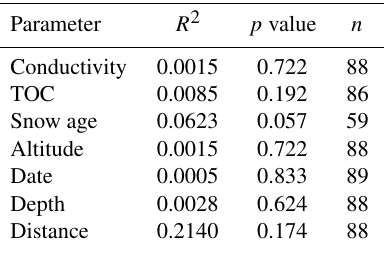
Table 2. Correlation analyses between T 50 values and different physicochemical and terrain parameters calculated with the Matlab standard linear fit model. R 2 values characterize the linear relation- ship between T 50 and the parameter; the p value identifies whether the correlation is statistically significant ( p value < 0.01 is consid- ered significant); n represents the number of snowmelt samples used in the